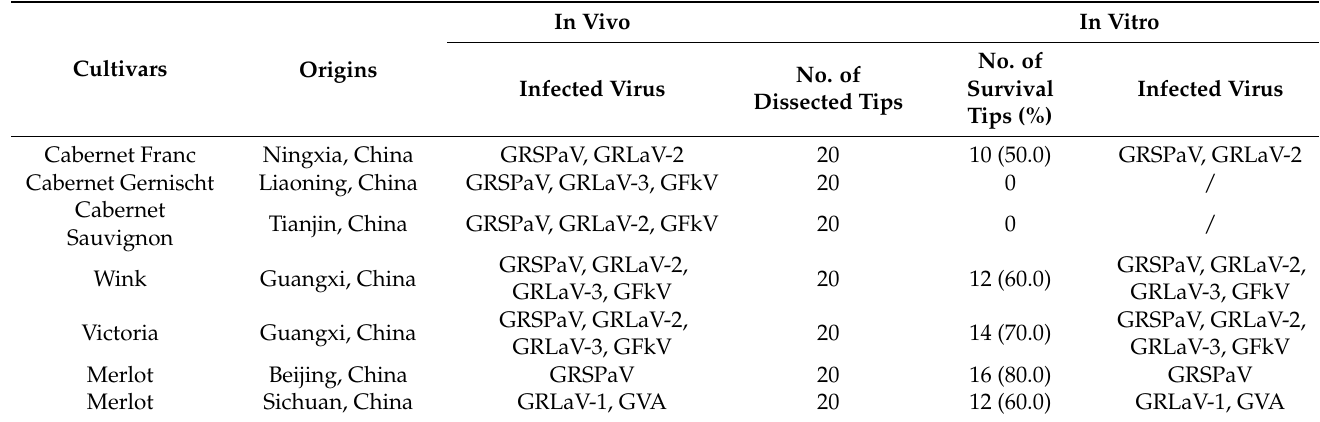
Both Wink and Victoria from Guangxi province were infected by grapevine rupestris stem pitting-associated virus (GRSPaV), grapevine leafroll-associated virus 2 (GLRaV- 2), grapevine leafroll-associated virus 3 (GLRaV-3), and grapevine fleck virus. Cabernet Franc from Ningxia and Merlot from Sichuan province were infected by two viruses (GRSPaV, GLRaV-1, GLRaV-2, GLRaV-3, GFkV, and GVA) have been found to be